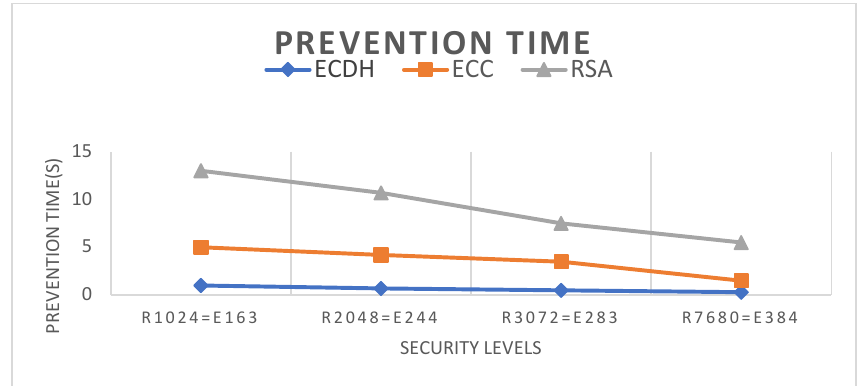
Figure 11. Prevention time.